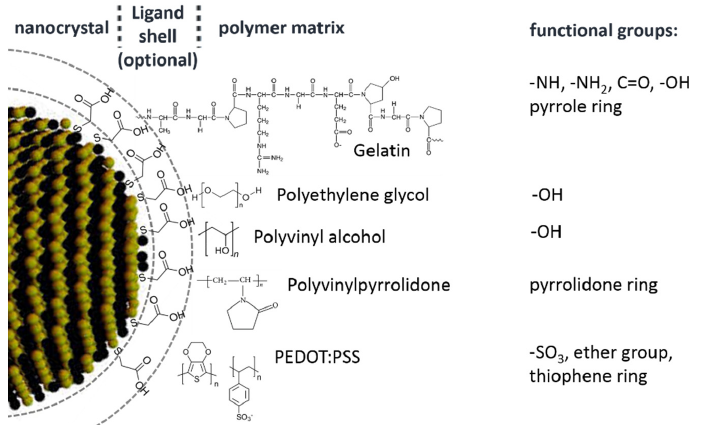
Figure 13. Schematic representation of the NC/polymer interface, including an optional ligand shell formed in case of ex situ synthesized NCs (see text for details and discussion).